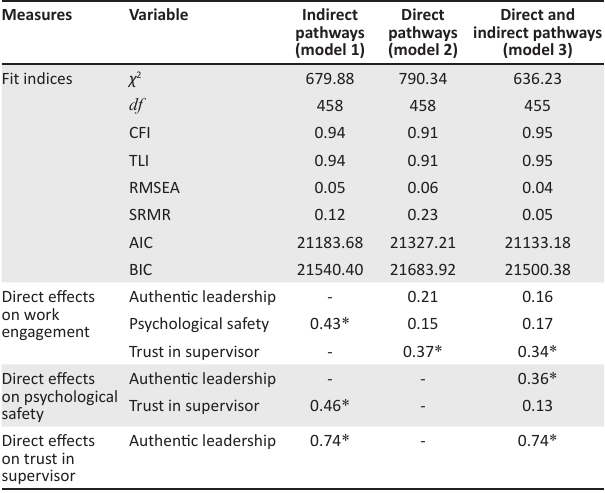
TABLE 3: Initial framework fit indices and standardised path coefficients.